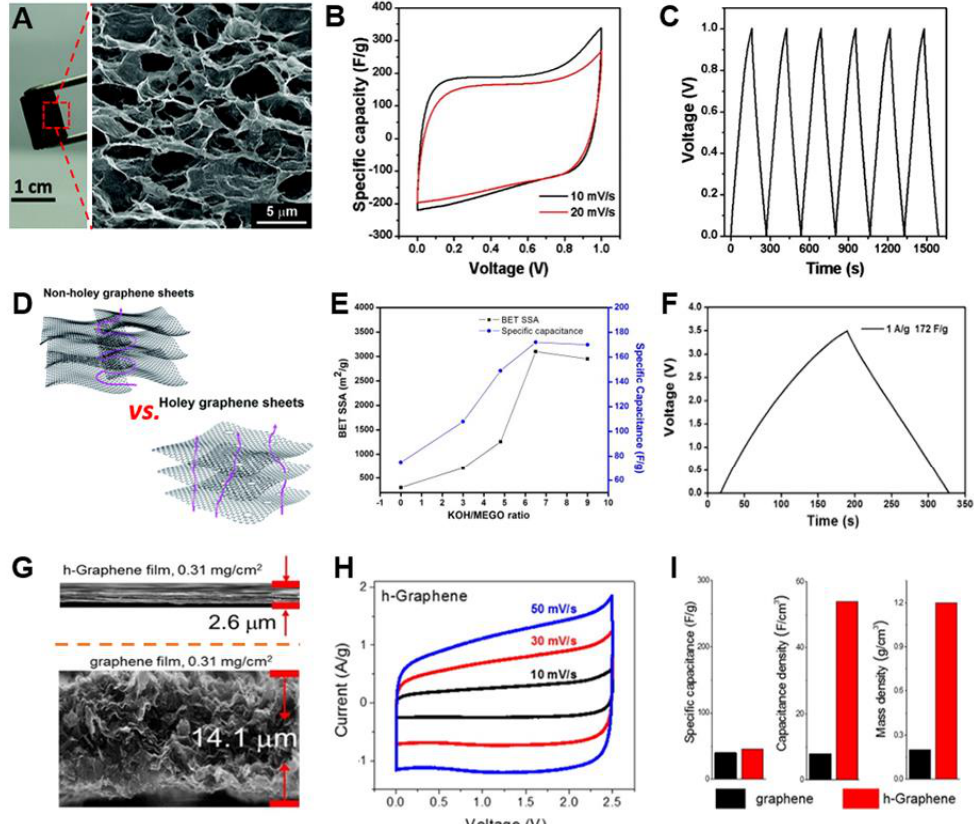
Figure 9. ( A ) Photograph and SEM images of the SGH material. ( B ) Cyclic voltammograms of the SGH-based supercapacitor at two different scan rates. ( C ) Galvanostatic charge/discharge curves of the SGH-based supercapacitor at a constant current of 1 A g −1 . ( A – C ) Reprinted with permission from Ref. [134], Copyright (2010) American Chemical Society. ( D ) Schematic representation of the comparison of the ion transport pathway of holey G sheets and non-holey G sheets. Reprinted with permission from Ref. [150], Copyright (2020) The Royal Society of Chemistry. ( E ) Effect of activation KOH/MEGO ratio on the surface area and specific capacitance of a-MEGO. ( F ) Galvanostatic charge/discharge curves of a-MEGO-based supercapacitor at different current densities. ( E , F ) Reprinted with permission from Ref. [101], Copyright (2012) Elsevier. ( G ) Cross-sectional SEM images of h-G and G films. ( H ) Cyclic voltammogram of the h-G electrode at various voltage scan rates. ( I ) Comparison of gravimetric and volumetric capacitance. ( G – I ) Reprinted with permission from Ref. [112], Copyright (2014) American Chemical Society.